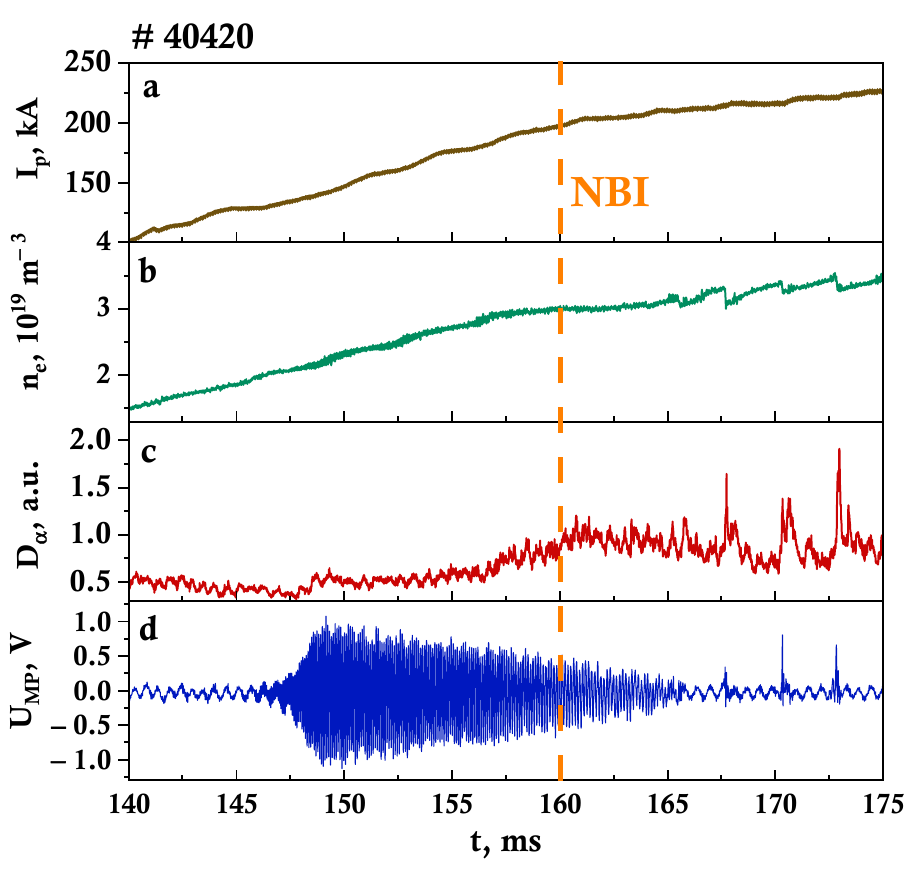
Figure 1. Globus-M2 plasma parameters for discharge #40420: ( a ) plasma current I p , ( b ) electron density n e , ( c ) D α signal, ( d ) magnetic probe signal U MP .